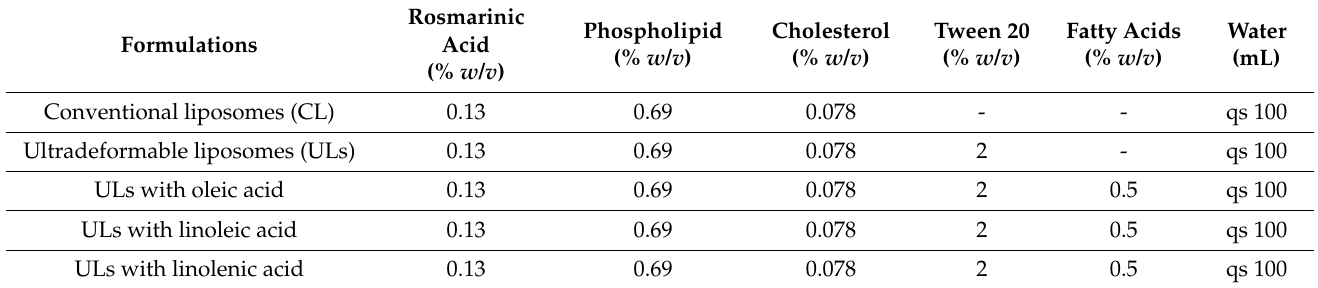
Table 1. Composition of liposomal